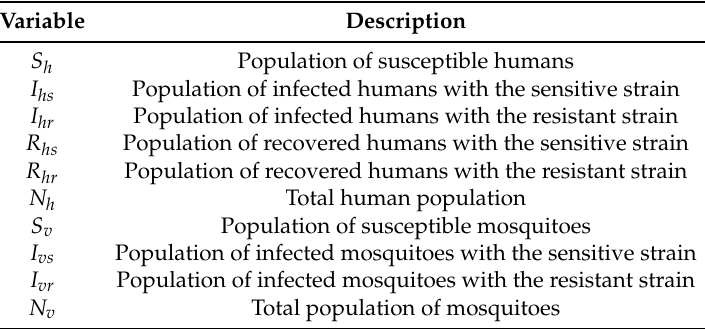
Table 1. Description of the state variable of the model.